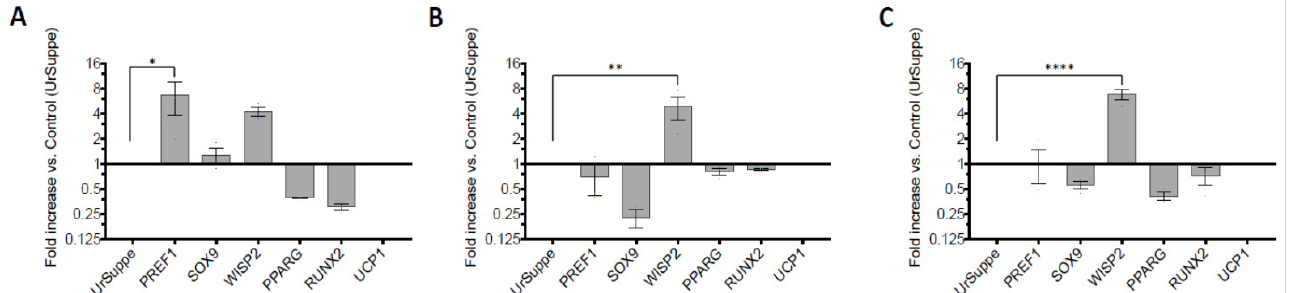
Figure 4. Relative expression levels measured by RT-qPCR of some essential genes influencing positively or negatively the differentiation process of hASCs. ( A ) hASCs cultured in US-24 with SAG and Insulin. ( B ) hASCs cultured in US-24 with SAG, Insulin, and Dex. ( C ) hASCs cultured in US-24 with SAG, Insulin, and TNF α . The normalized expression ratios of the six markers measured for hASCs cultured with the three US-24 media were related to the values obtained with cells grown in UrSuppe medium ( n = 3, error bars represent S.E.M., p value; *: p value < 0.05; **: p value < 0.01; ****: p value < 0.0001). UCP1 mRNA was undetectable in the three